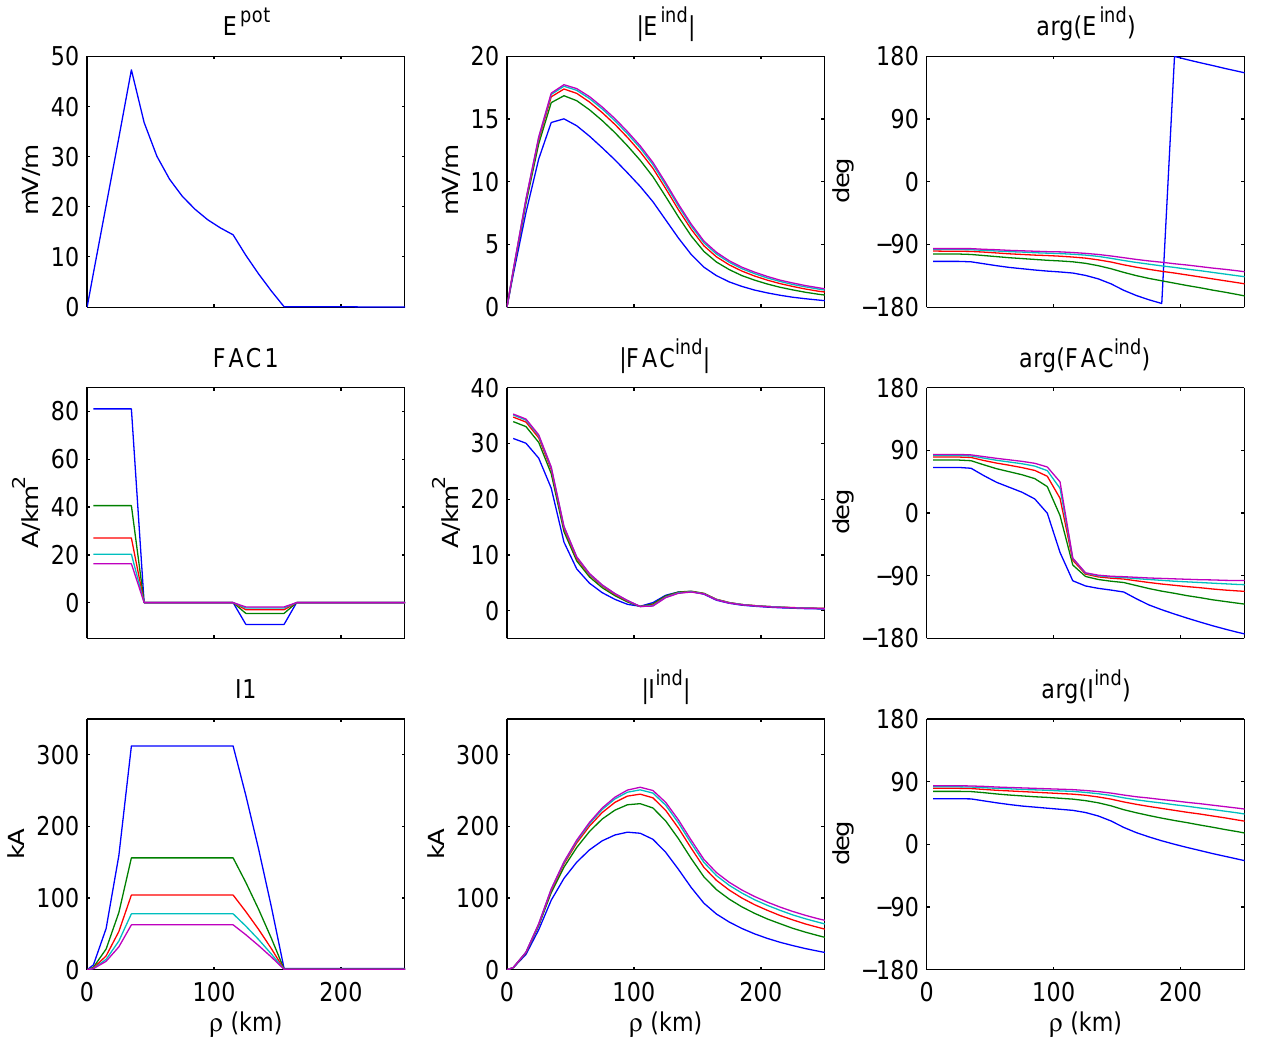
Fig. 3. Similar to Fig. 2, but now the Pedersen conductance 6 P is varied while keeping the oscillation time T and Hall conductance 6 H constant. In these examples T = 8s and 6 H = 30S, while the Pedersen conductance is 6 P =30, 6 P =15, 6 P =10, 6 P =7.5 and 6 P